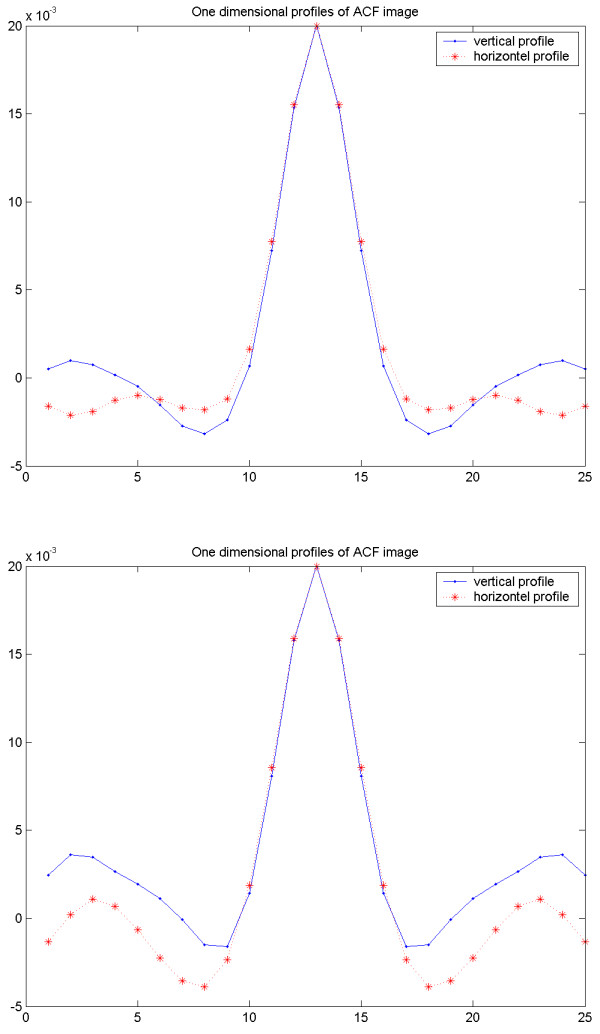
Results of the elliptical torso phantom study. Vertical (dash point) and horizontal profile (dash star) through the centre of the ACF image obtained with 2D (upper) or 3D acquisition (lower) reconstructed using OSEM with 6 mm Gaussian filter.